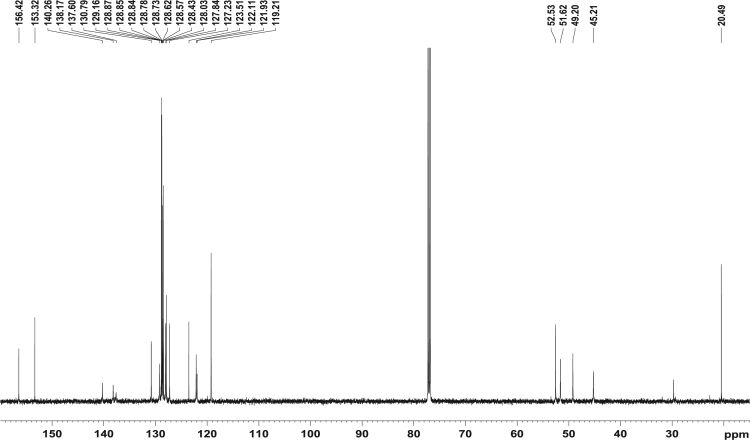
13C NMR spectrum of ligand S1.